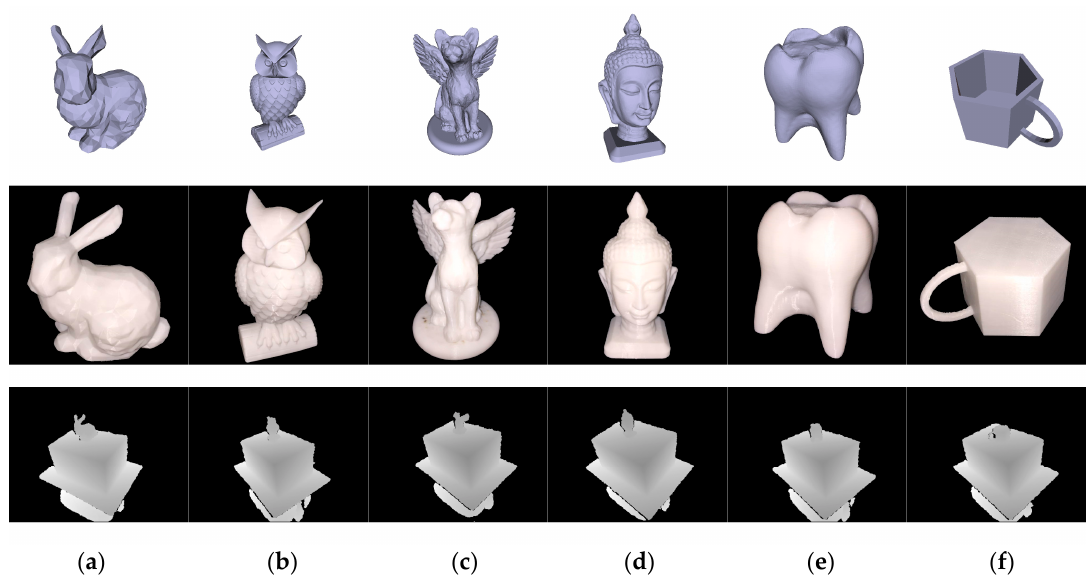
Figure 9. Real-world data: ( a ) lambunny; ( b ) owl; ( c ) wingedcat; ( d ) buddhahead; ( e ) tooth; and ( f ) mug. The top row shows the snapshots of the GT models, the middle row shows the 3D printed rigid objects, and the bottom row shows the depth images of models placed on our man-made cuboid resting on a turntable.